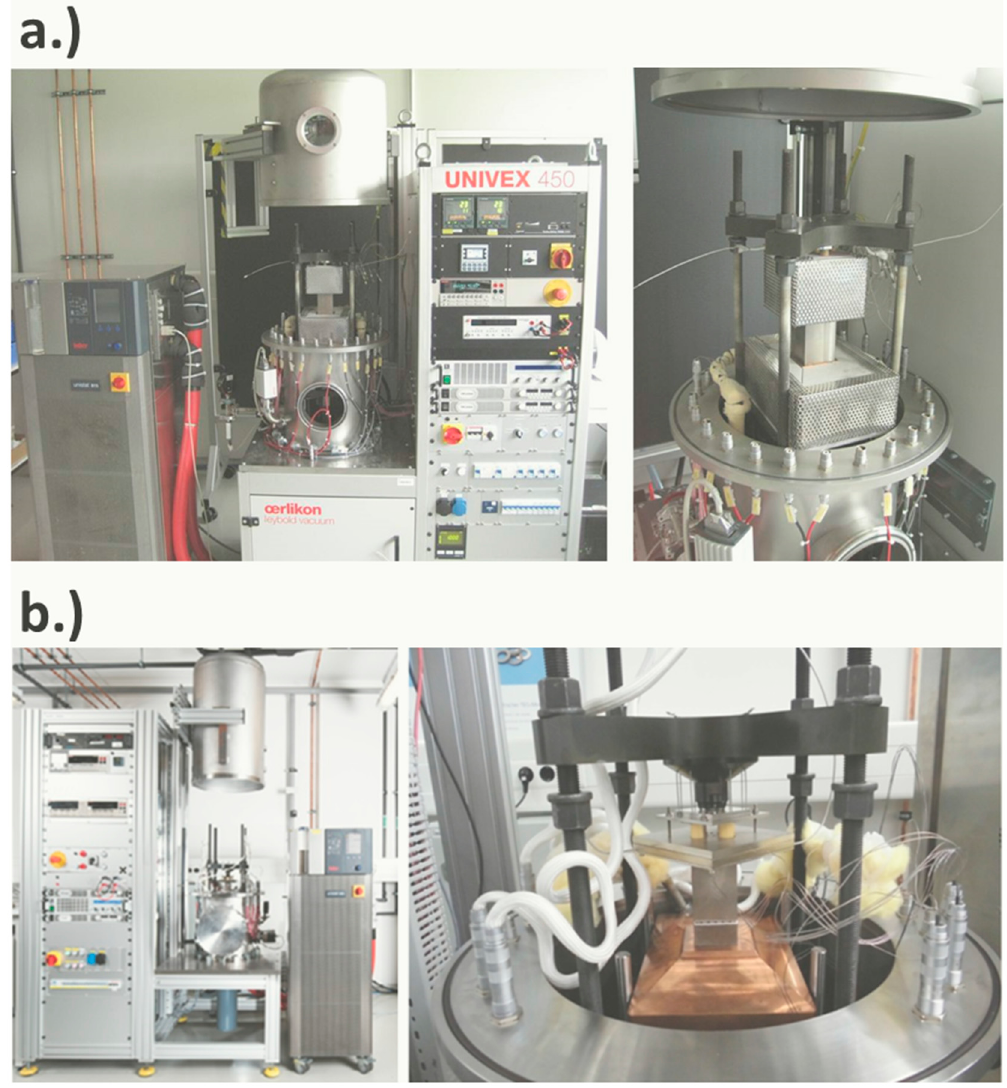
Figure 2. “A-TEGMA” ( a ) and “TEGMA” ( b ) devices for TEM characterization.